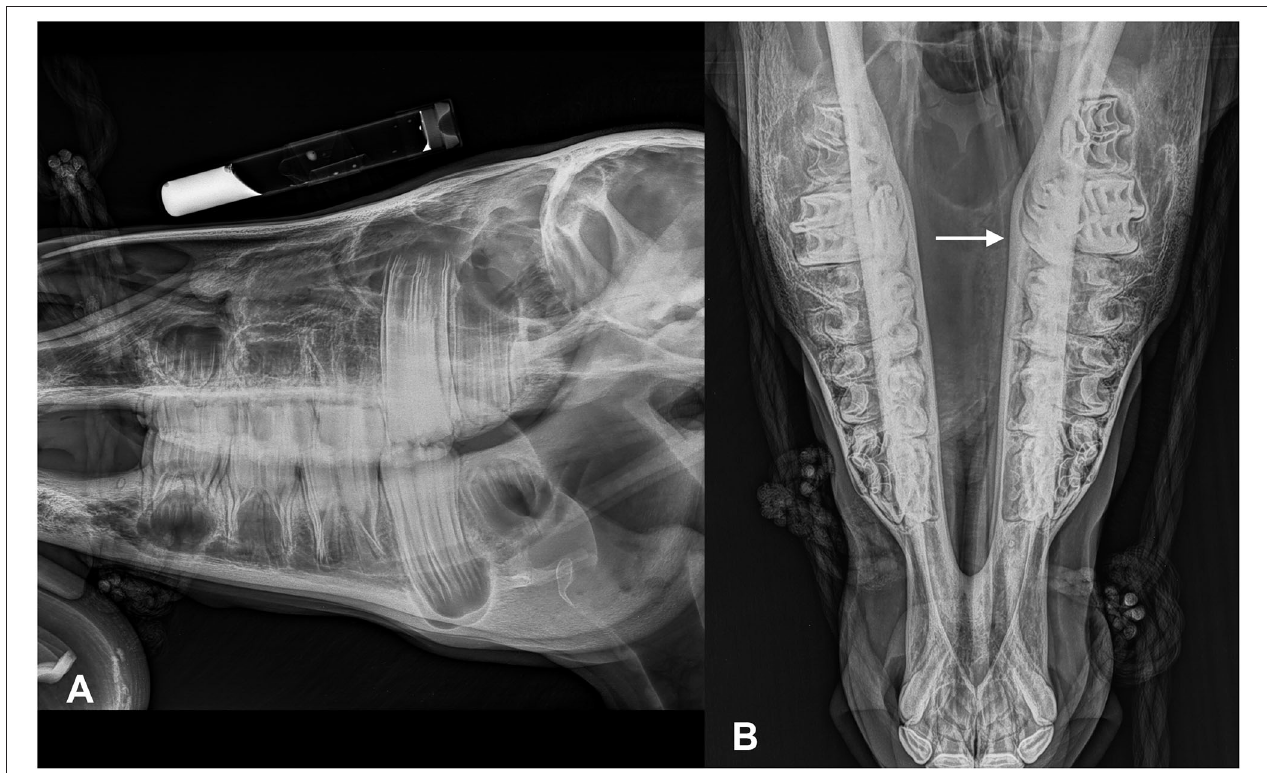
FIGURE 1 | Lateral (A) and dorsoventral (B) (left in the image is right of the patient) radiographic views of mini-Shetland pony (case 6) presented with bilateral disease. Note that the sinus compartments demonstrate a diffuse soft tissue opacification. The nasal septum is severely deviated toward the left side (white arrow).